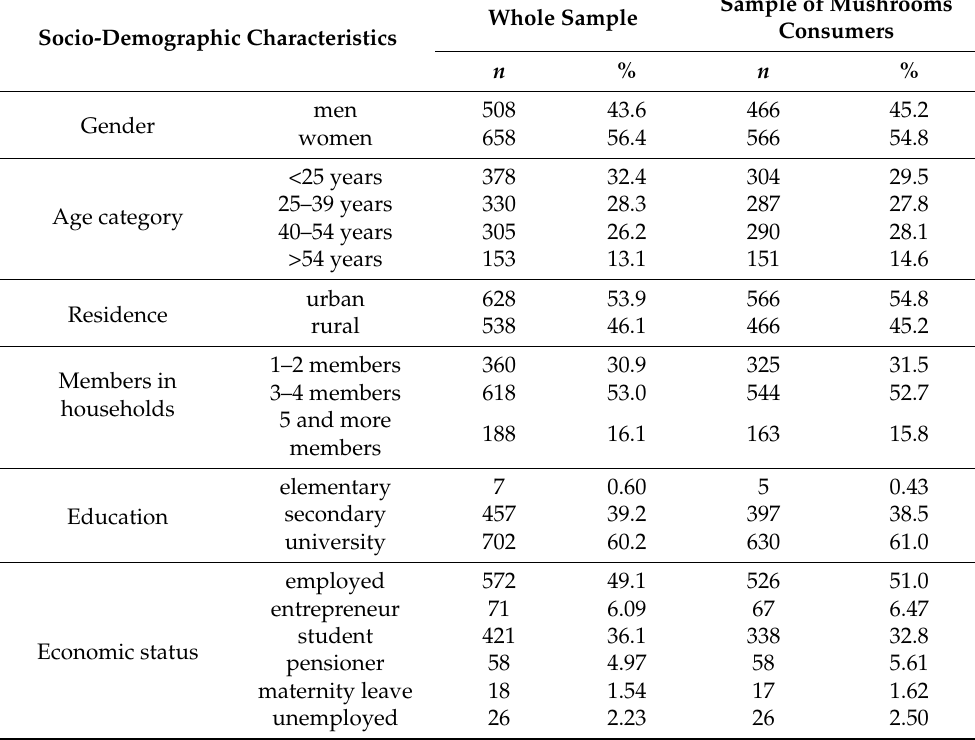
Table 1. Socio-demographic characteristics of respondents.